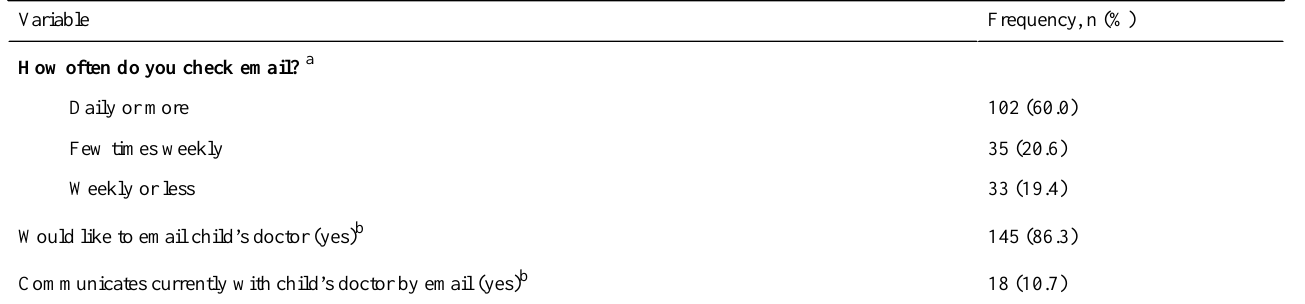
Table 2. Practices of email users.